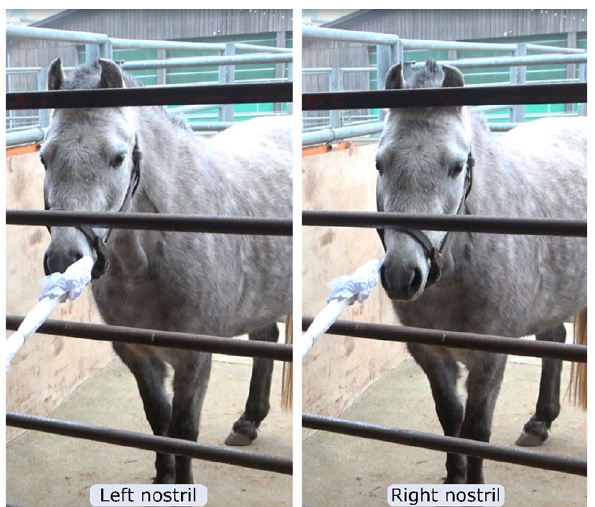
Figure 2. Example of a subject using her left or right nostril to sniff the sample. Photograph courtesy of Plotine